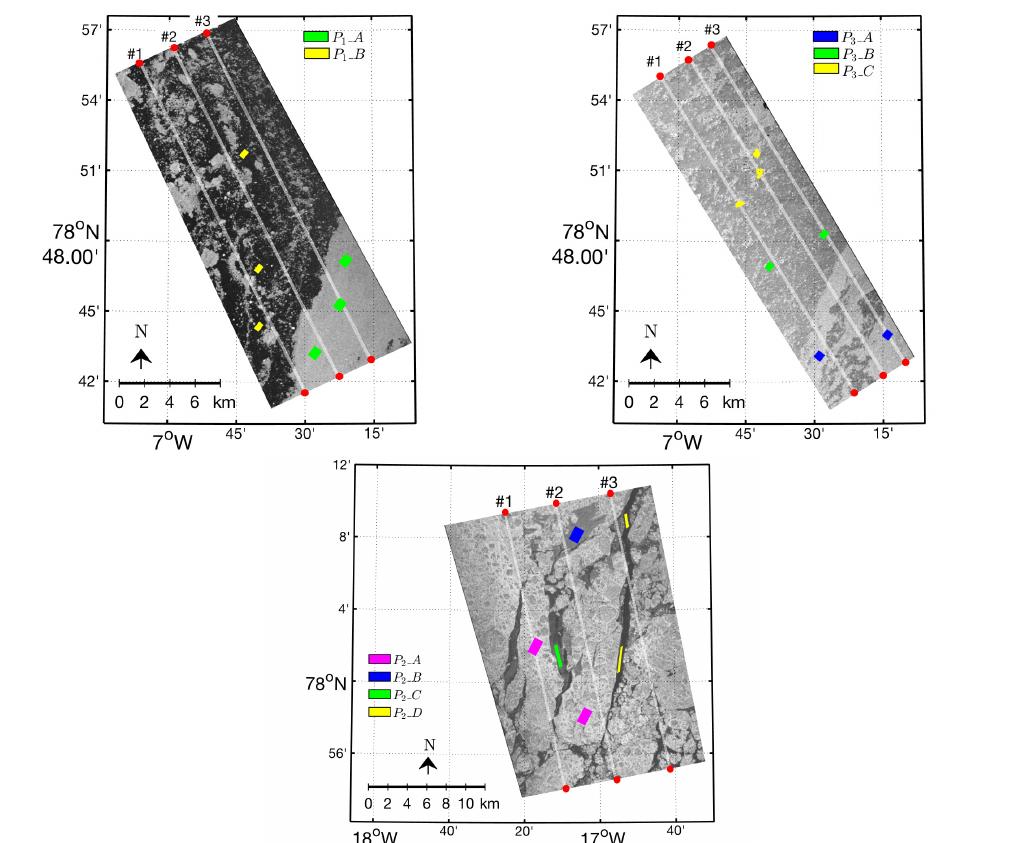
Figure 5. Illustrations of the regions of interest (ROIs) investigated. The ROIs are overlaid on top of RI-1 scenes for P 1 ( top left ), P 2 ( bottom ), and P 3 ( top right ). The profiles are indicated by light gray colored line between two red markers. The profiles are 50 pixels wide and passes through the azimuth